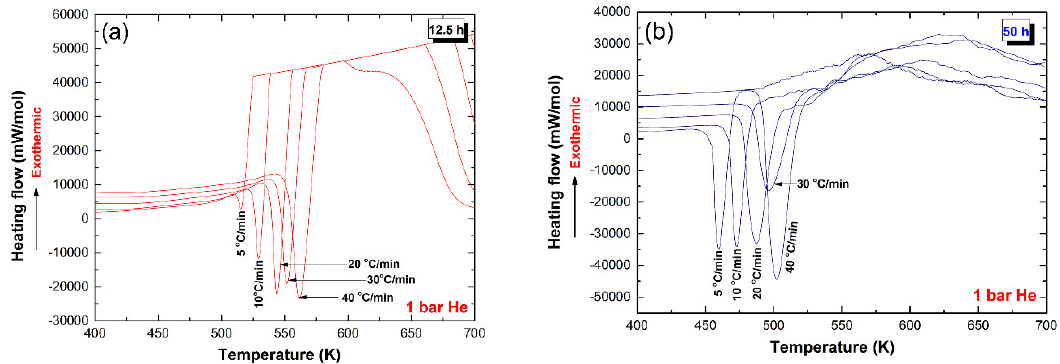
Figure 5. Decomposition behavior of as-synthesized nanocomposite MgH 2 /5 wt% (2.5 ZrNi 5 + 2.5 Nb 2 O 5 ) powders. Normal pressure-DSC curves achieved under 1 bar of He gas at different heating rates are displayed for the powders obtained after ( a ) 12.5 h and ( b ) 50 of milling time. .